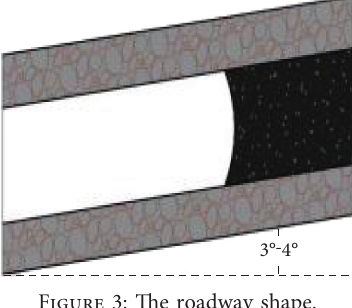
Figure 3: The roadway